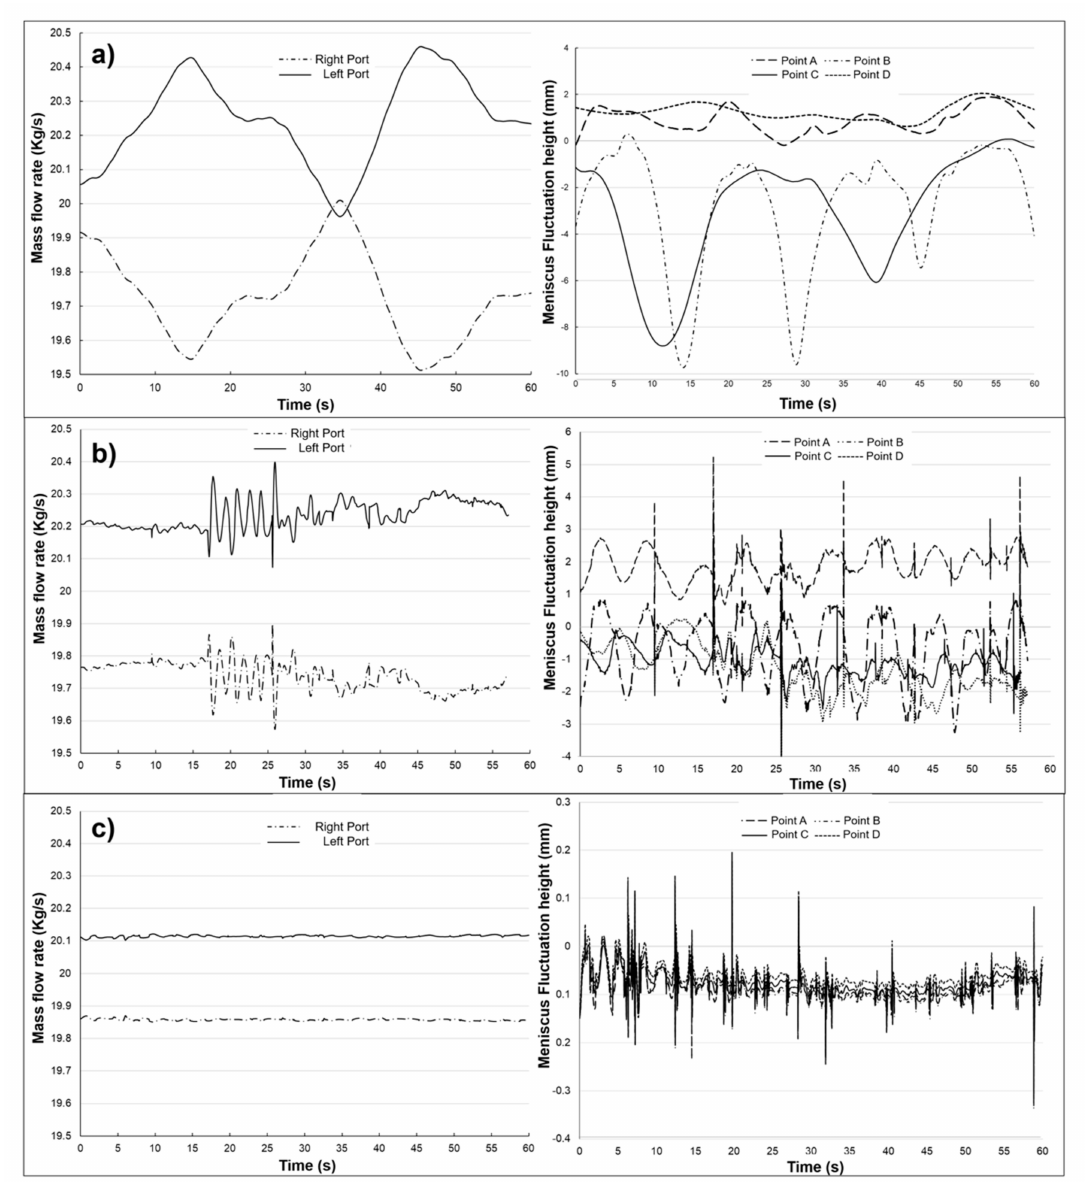
Figure 9. Mass flow rate in the SEN ports and meniscus fluctuation height during 60 seconds at unsteady-state conditions, H-EMBr, ( a ) 0, ( b ) 0.1 and ( c ) 0.2